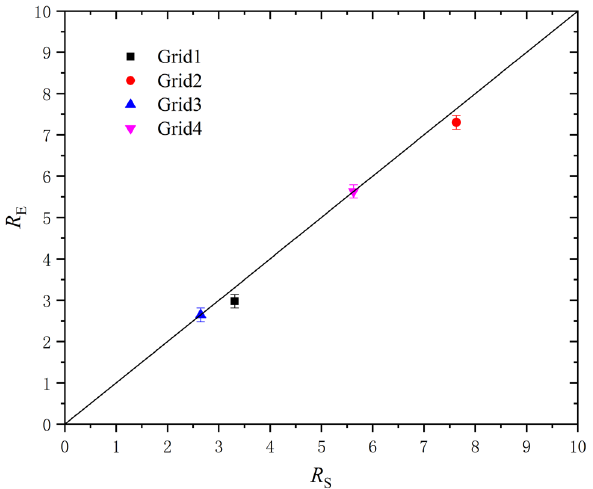
Fig. 8 Plot of the experimental R E versus simulated R S values of the minimum electric field ratio. The different symbols refer to different grids. The error bars arise from the spacing of the voltage setting in the experiment